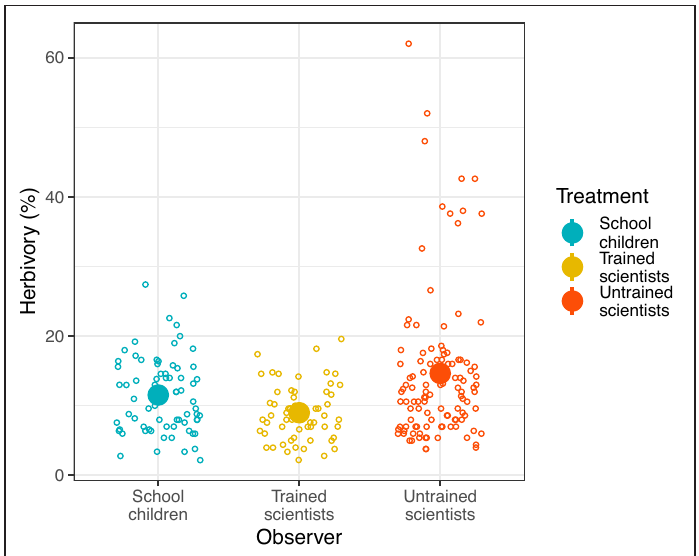
Figure 3: Comparisons between insect herbivory as estimated by school children, trained scientists, and untrained professional scientists. Empty dots represent individual observations (i.e., a single assessment on a particular leaf set). Filled circles and vertical bars represent means ± SE of the raw